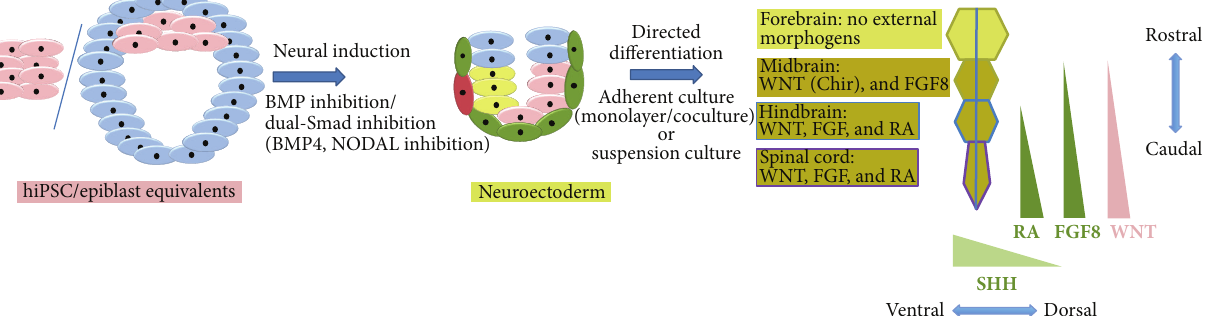
Figure 5: Methods for directed differentiation: hPSCs can be directed to undergo neural conversion by applying developmental principles of inhibiting BMP4 and/or Nodal. From neuroectoderm, differentiation of different neuraxial regions can be achieved by recapitulating developmental morphogenetic instruction: forebrain (default), midbrain (WNT, FGF8 activation), hindbrain (WNT, FGF8, and others, RA), and spinal cord (WNT, FGF8, and others, RA). These gradients are shown on the right of the figure for the rostrocaudal axis. Another important morphogenetic cue used in directed differentiation is SHH for its ventralising effect within the D-V axis. All timelines are given for mouse and human embryonic